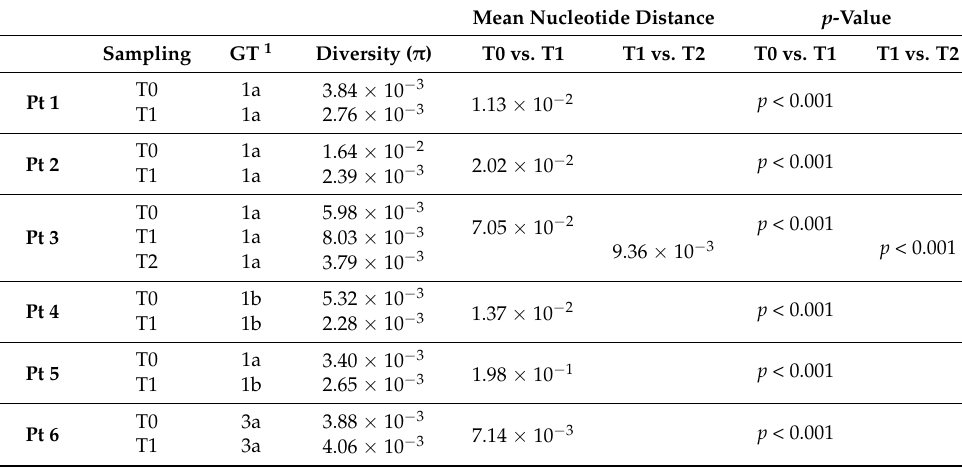
Table 2. NGS intra-sample diversity and intra-patient nucleotide distances. Mean Nucleotide Distance p -Value Sampling GT 1 Diversity ( π